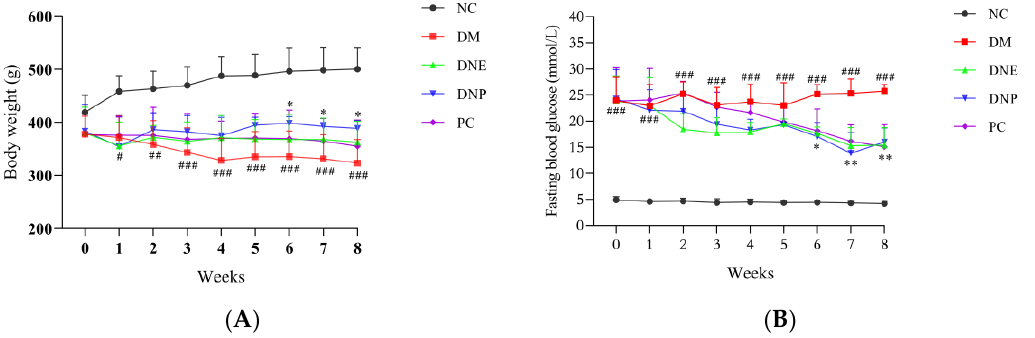
Figure 9. Effects of D. nobile on body weight ( A ) and FBG ( B ) of T2DM rats. All data are expressed as mean ± S.D. (n = 6 per group). Compared with the NC group, # p < 0.05, ## p < 0.01, and ### p < 0.001; compared with the DM group, * p < 0.05 and ** p < 0.01.